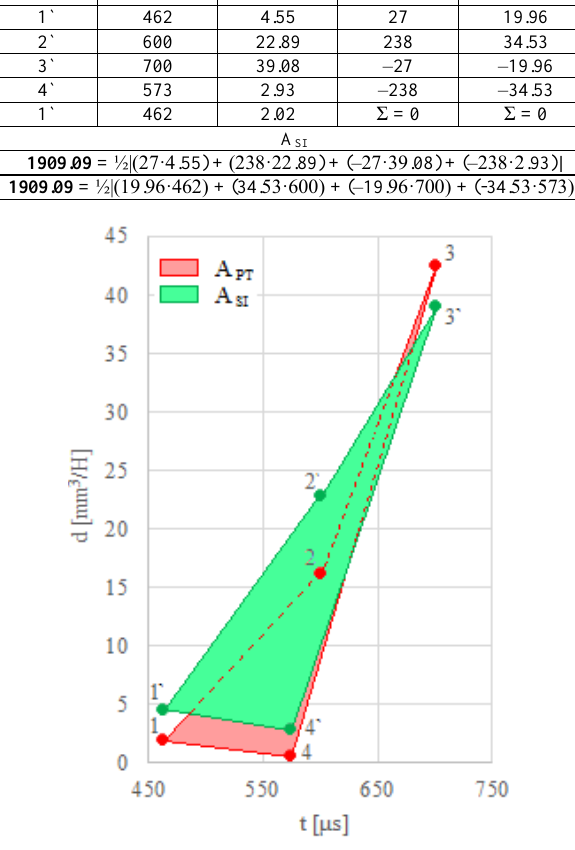
Fig. 3. Graphical interpretation of the preliminary test results